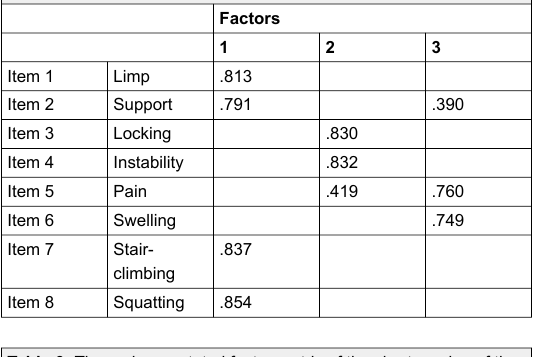
Table 5: The varimax-rotated factor matrix of the Lysholm score (factor loads <0.3 suppressed). Factors